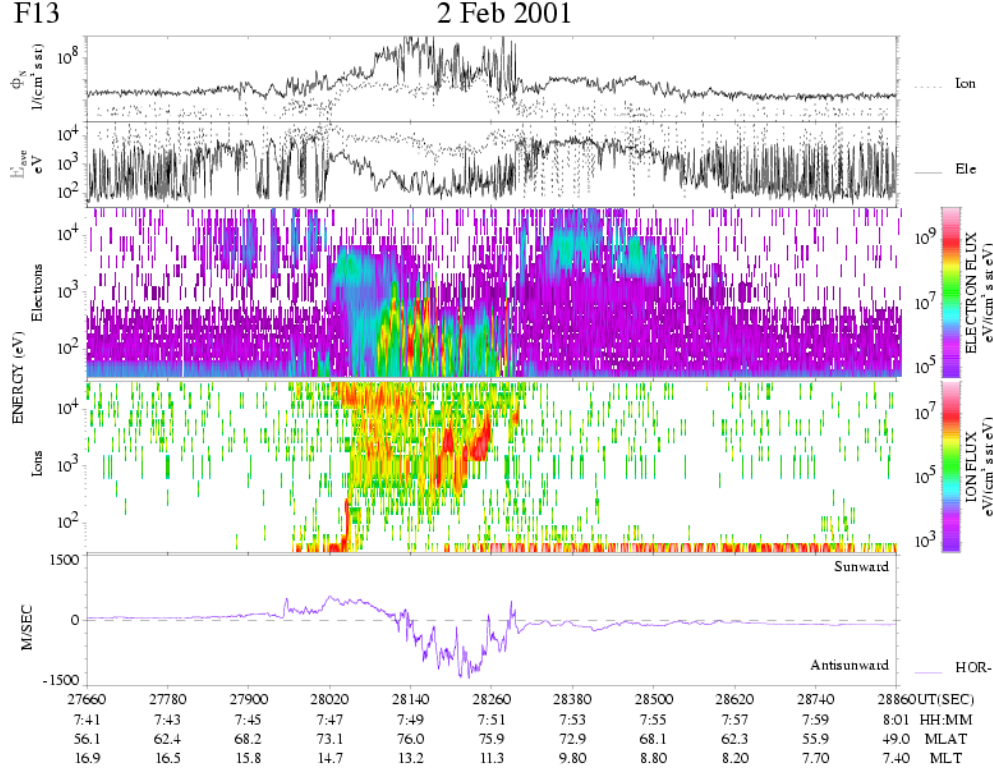
Fig. 7. DMSP data from the SSJ/4 instrument between 07:41 and 08:01UT on